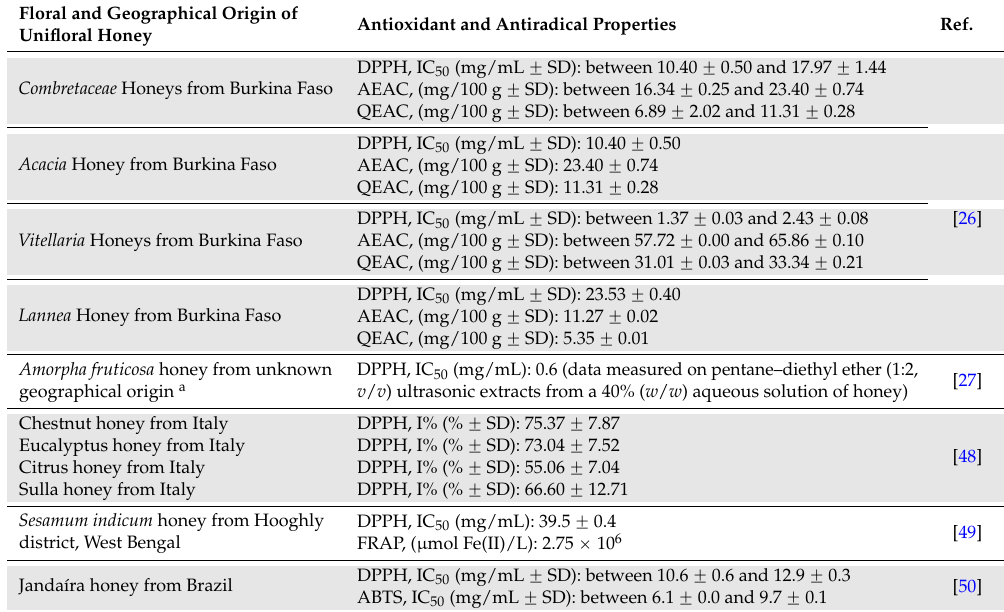
Table 2. Antioxidant and antiradical properties of unifloral honeys. Floral and Geographical Origin of Antioxidant and Antiradical Unifloral Honey